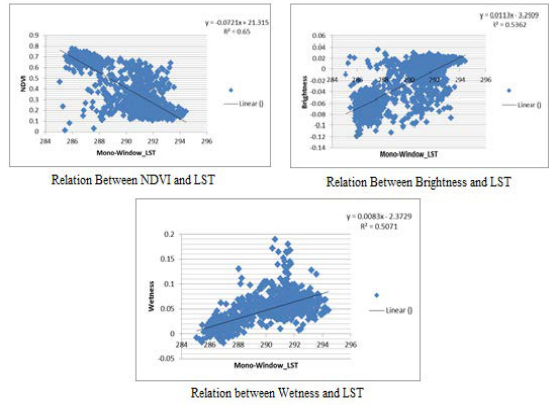
Table 10. Relation Between Greenness, Brightness and LST values for same coordinate locations.